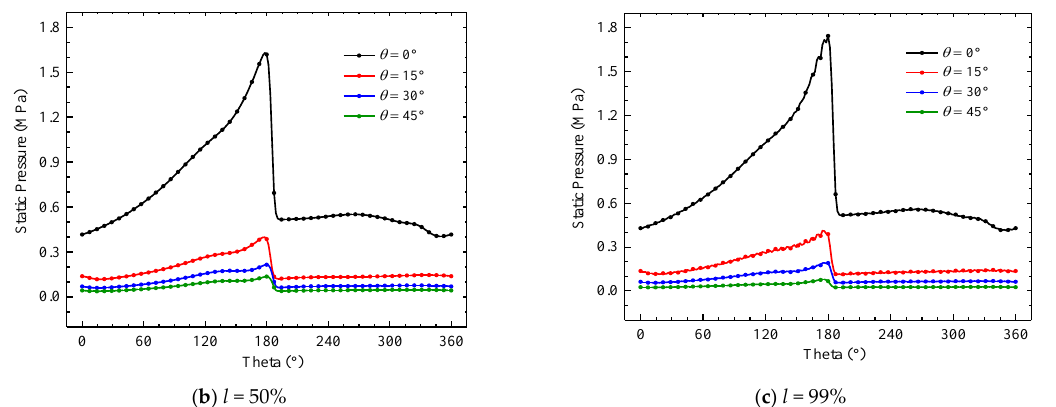
Figure 15. The circumferential outlet static pressure distribution of the RDC at t = 3980 μs. The improvement of the pressure distribution at the RDC outlet is due to the adoption of the diverging nozzle. However, it cannot be ignored that the pressure gain performance of the RDC is reduced accordingly. Fortunately, the combustors with different diverging nozzles still maintain pressure gain effects (i.e., π c > 1). Obviously, there is inevitably a loss of mixing in the diverging section due to the acceleration process of the gas flow, so the entropy distribution of the combustor with the diverging nozzle needs to be evaluated, as shown in Figure 16. In the chemical reaction zone, the entropy gradually increases from the inlet. When it enters the position of X = 150 mm to X = 200 mm, the entropy of θ = 0° tends to be stable, while the entropy of θ = 15°, 30°, and 45° continues to increase here. It confirms that the flow loss for θ = 15°, 30°, and 45° is larger than that of θ = 0°, resulting in the pressure gain performance decreasing.